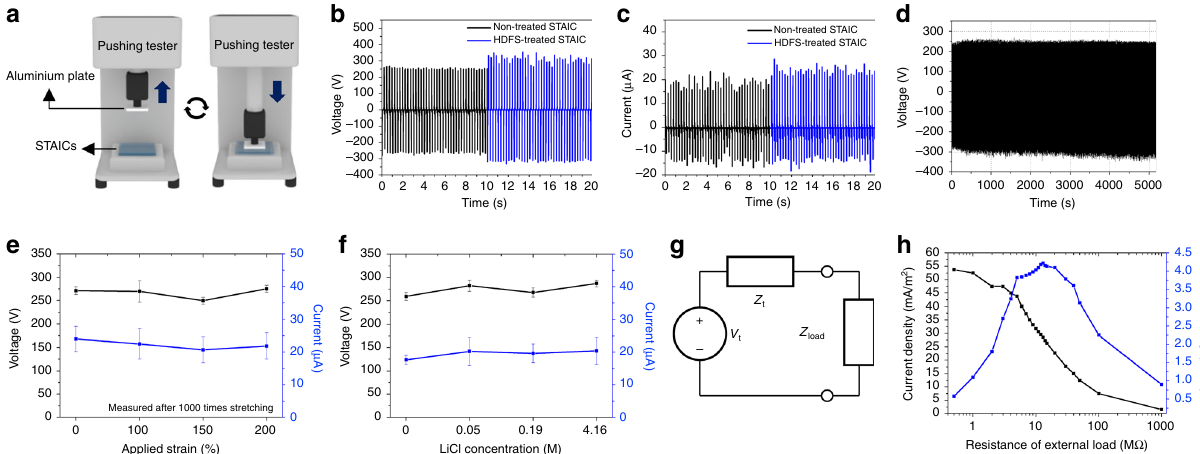
Fig. 2 Triboelectric characterization. a Triboelectric performances were investigated with a pushing tester which can provide consistent contact area and speed (Heptadeca fl uoro-1,1,2,2-tetrahydrodecyl)trichlorosilane (HDFS) treatments for the self-cleanable, transparent and attachable ionic communicator (STAIC) enhanced b 24.5% of output voltage and c 17.5% of output current. d Durability of a STAIC was tested for 25,600 cycles. e Triboelectric outputs were measured after 1000 times of uniaxial stretching. 100%, 150% and 200% of strain were applied. f Effect of salt concentration on triboelectric outputs. g Thévenin equivalent circuit to deliver power to an external load ( Z t : Thévenin impedance, V t : Thévenin voltage, Z load : External load). h Output current density and output power density of a STAIC with various external loads. All error bars in the fi gure represent standard error of the mean of the